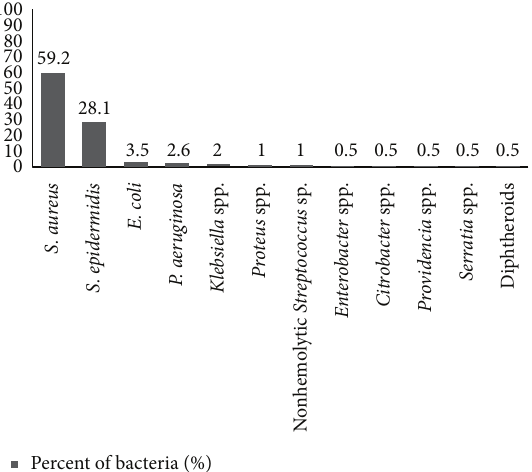
Figure 1: Etiological agents of skin and soft tissue infection of pem- phigus patients.